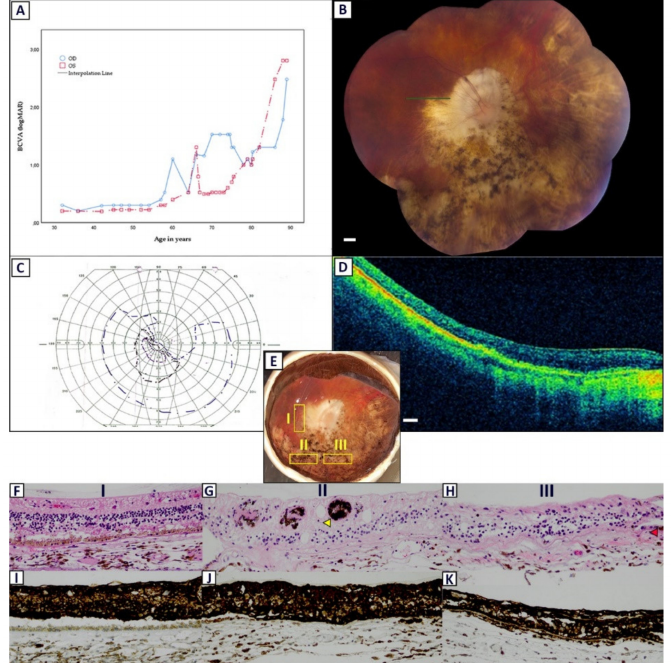
Figure 4. Clinical characteristics and postmortem histopathological examination in patient I-10 at the age of 94, who carried the p.Glu1031Glyfs*58 (c.3092del) mutation in RPGR . ( A ) A line graph detailing the best-corrected visual acuity (logMAR) course regression in this patient. A cataract extraction was performed at the age of 66 (left eye; OS) and 74 (right eye; OD). For hand movement vision, light perception vision, and no light perception, logMAR values of 2.7, 2.8, and 2.9 were used,